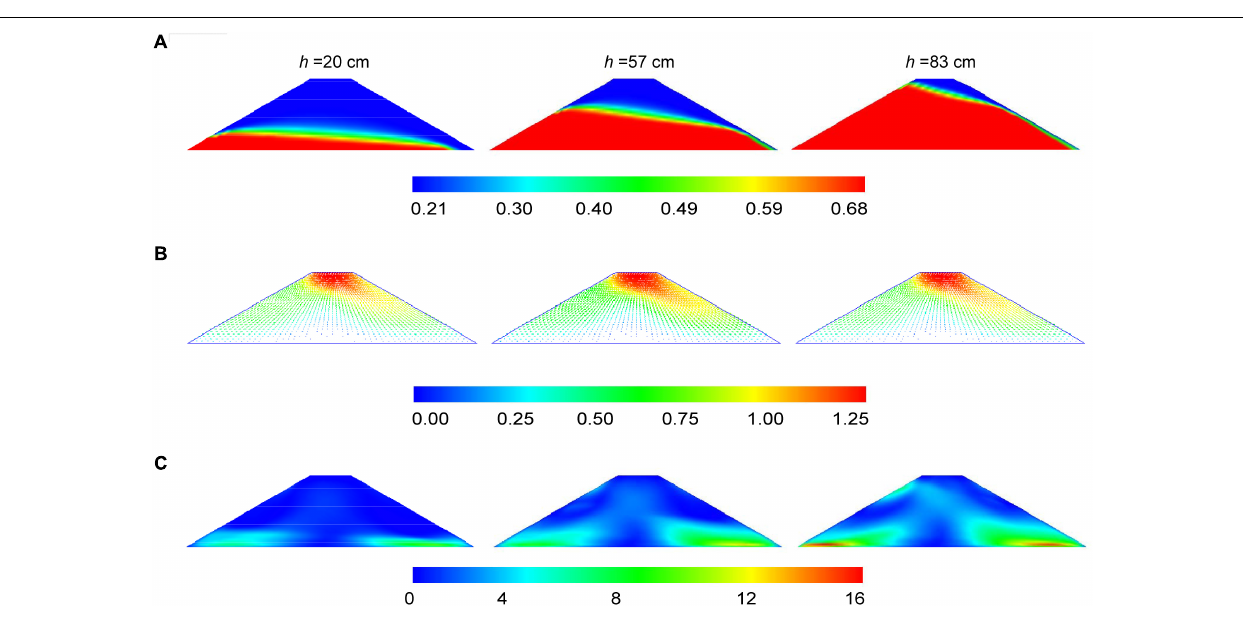
should be used as the criterion for pipe progression to account for the scale effects observed between large- and small-scale experiments (Robbins, 2016). Based on a rational constitutive model for a saturated/unsaturated soil (Zhang and Ikariya, 2011),